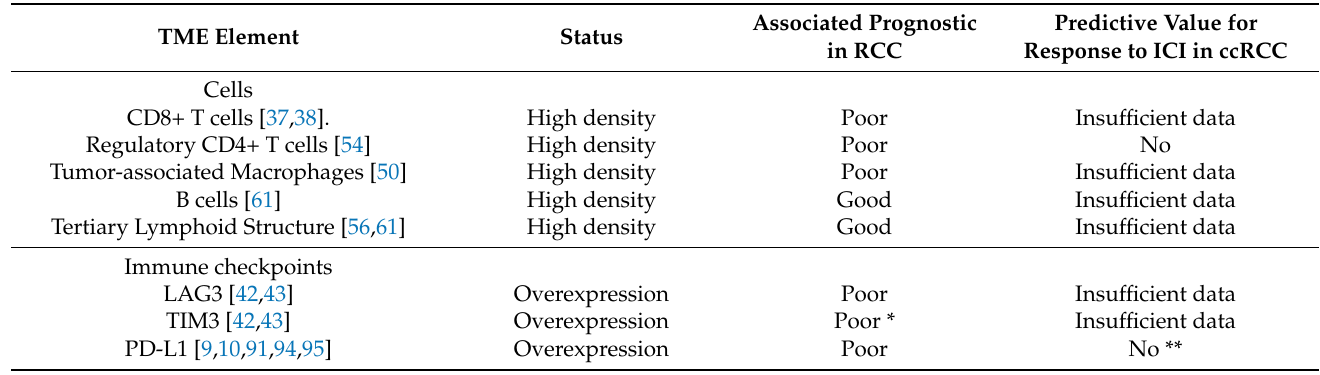
Table 1. Prognostic and predictive value of the major TME components in RCC.